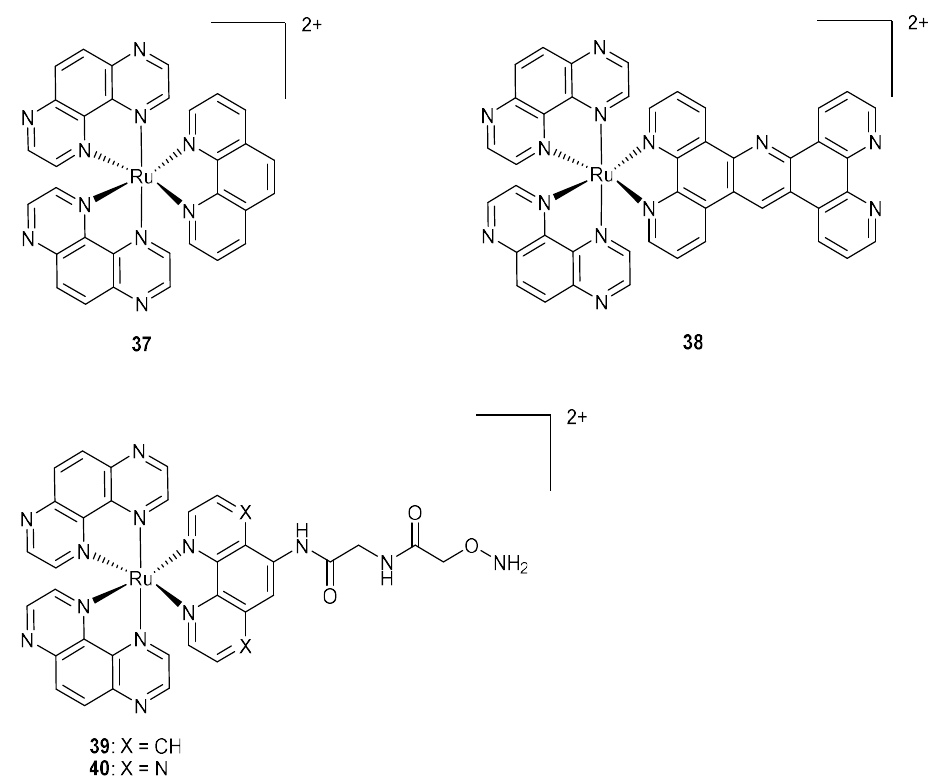
Figure 14. Structures of the Ru complexes [Ru(TAP) 2 Phen] 2+ 37, [Ru(TAP) 2 (TPAC)] 2+ 38 [131], 2+ 39 , and [Ru(TAP) 2+ 40 [Ru(TAP) 2 phen’] 2+ 39 , and [Ru(TAP) 2 TAP’] 2+ 40 [132]. [Ru(TAP) 2 phen’] 2 TAP’]